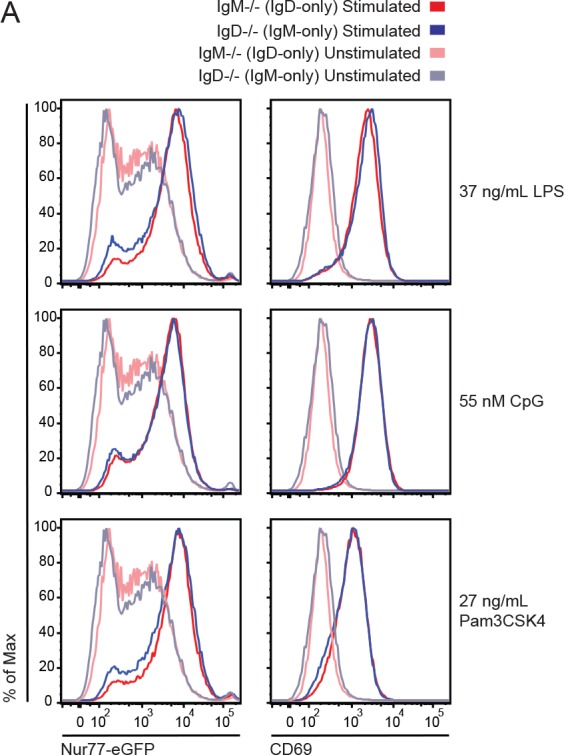
Induction of Nur77-eGFP and CD69 in TLR-stimulated IgM−/− and IgD−/− B cells.(A) Nur77-eGFP and CD69 upregulation in IgM−/− and IgD−/− splenic B cells stimulated with indicated doses of LPS, CpG, and Pam3CSK4. Histograms compare unstimulated cells with cells incubated with indicated stimuli for 18 hr at 37C. Histograms are representative of two independent experiments.